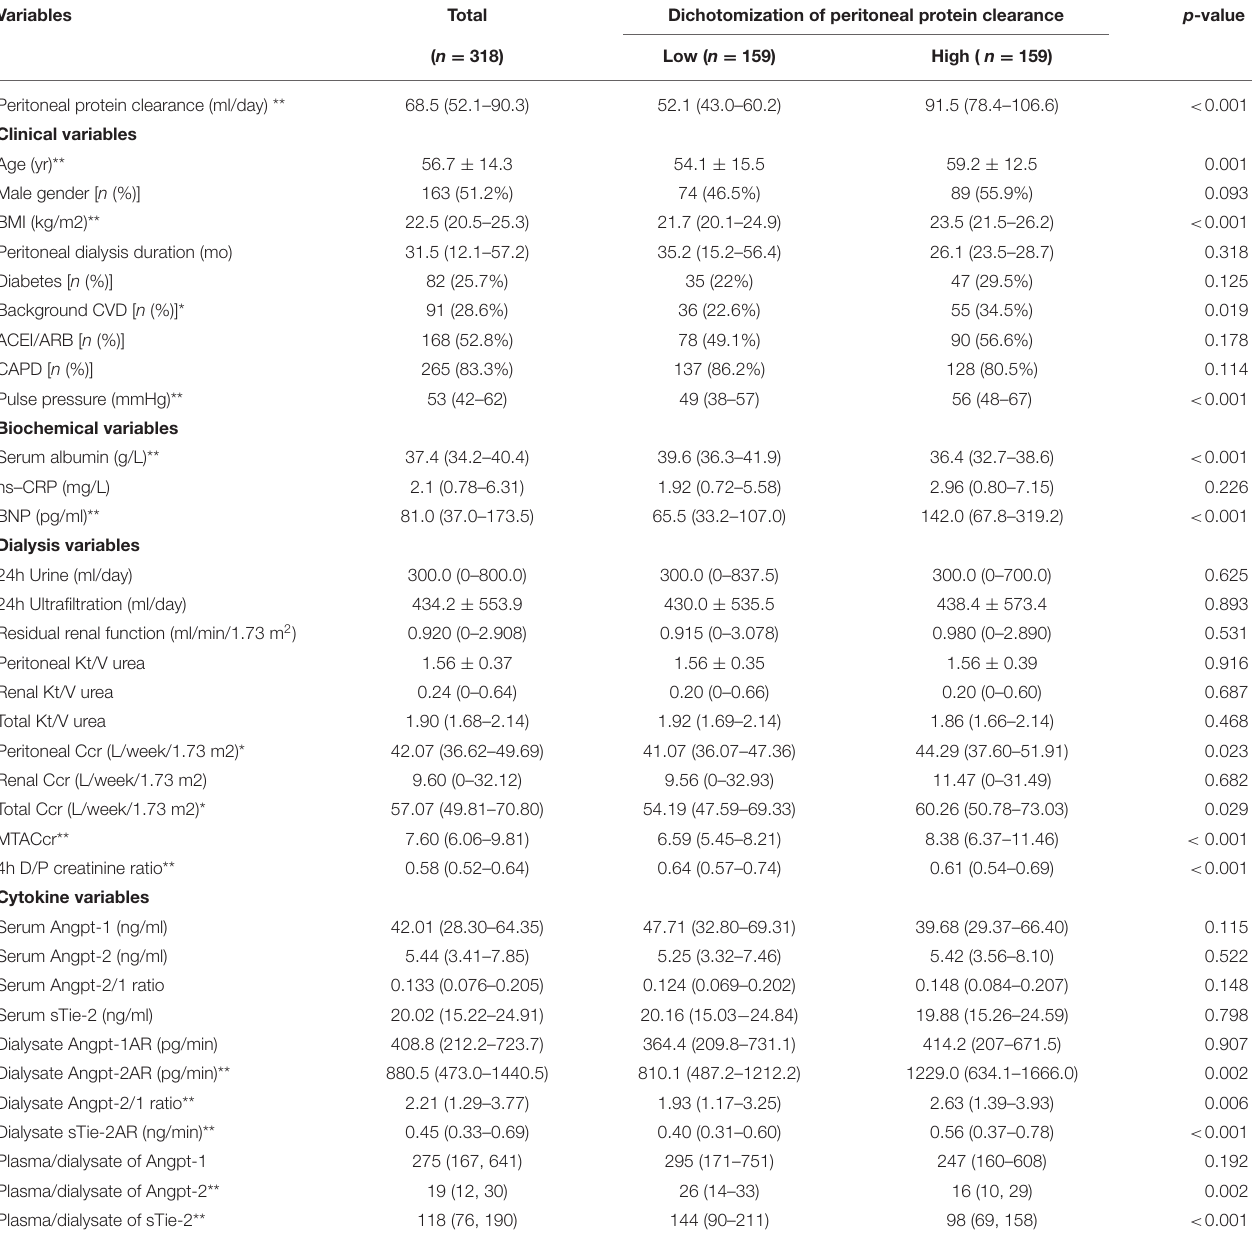
TABLE 1 | Demographics, biochemical variables, peritoneal transport, local, and systemic Angpt-Tie2 system cytokines in the subgroups dichotomized by peritoneal protein clearance.